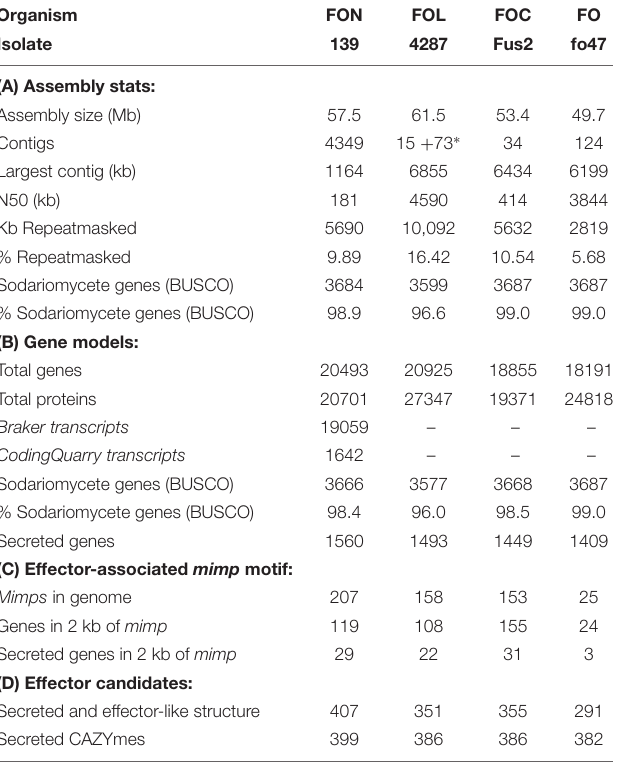
TABLE 2 | Genomic statistics for FON139 and reference genomes for FOL, FOC and FO. Organism